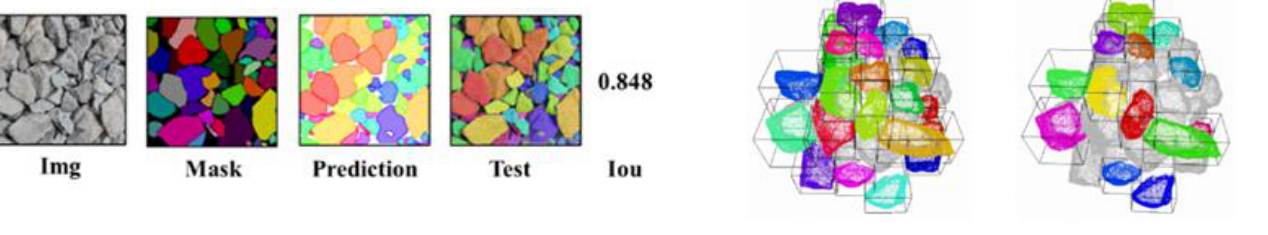
Figure 5. Segmentation of individual grains in bulk material. ( left ) from 2D images [18], ( right ) from 3D point cloud [19].